Question: According to this chart, does the measure grow or shrink?
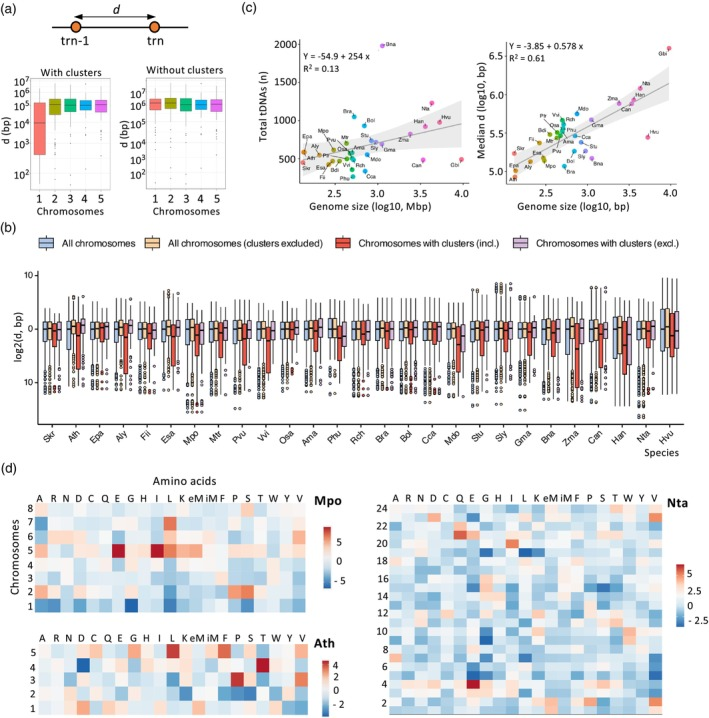
Answer: increasing